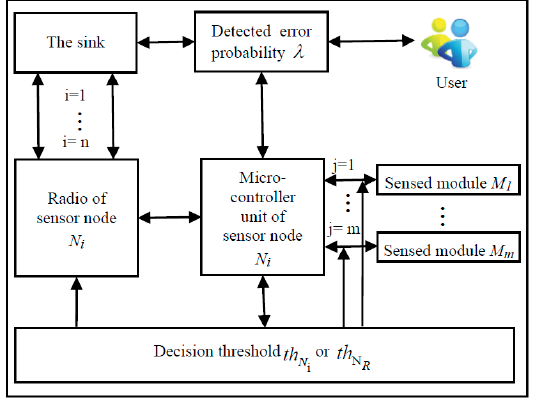
Figure 2. Schematic diagram of sensed modules management